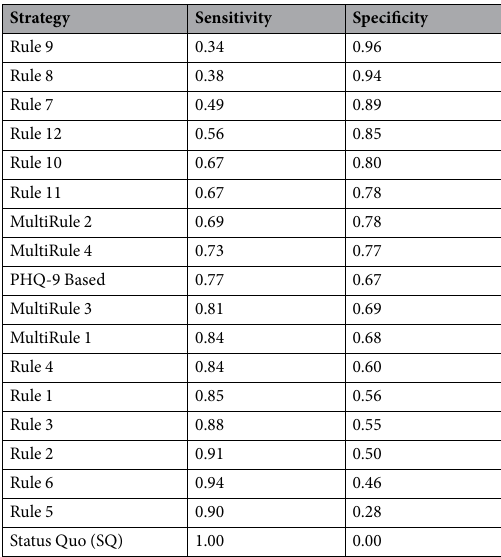
Table 4. Monitoring outcomes of all strategies (N = 562